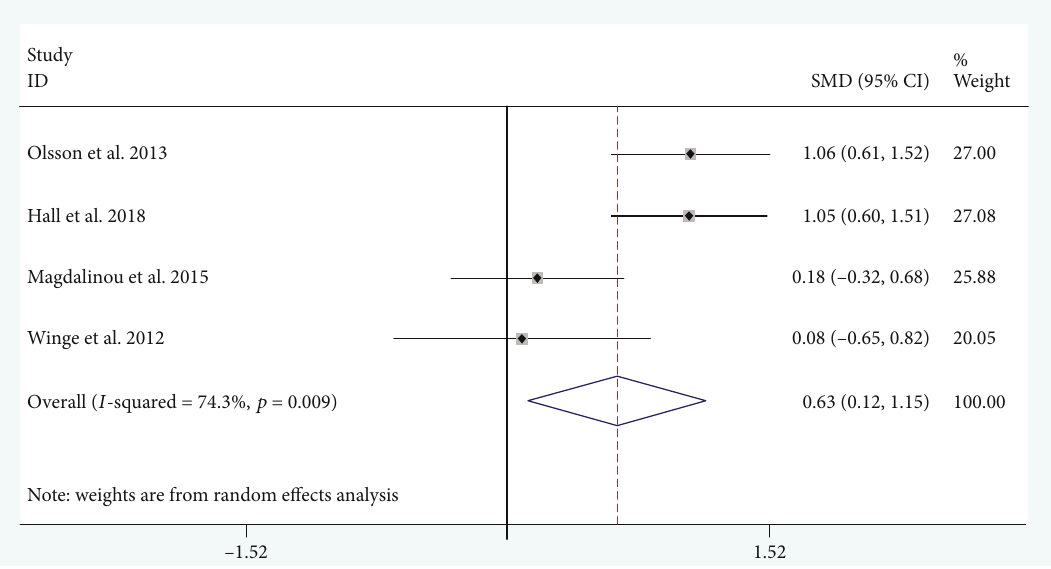
Figure 5: Cerebrospinal fl uid (CSF) levels of YKL-40 in multiple system atrophy (MSA) cohorts were higher than those in Parkinson ’ s disease (PD)